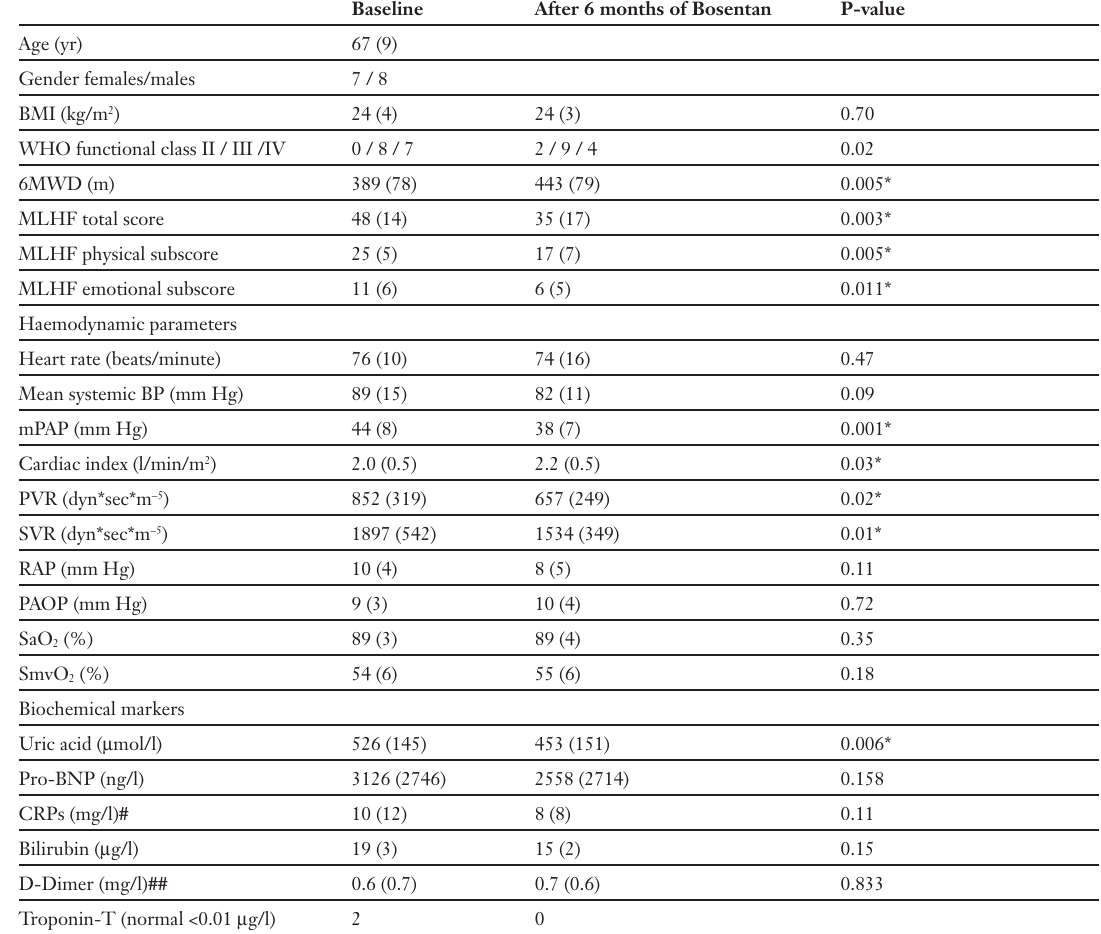
Table 1 Characteristics of 15 patients with Chronic Thromboembolic Pul- monary Hypertension at baseline and after 6 months of Bosen- tan